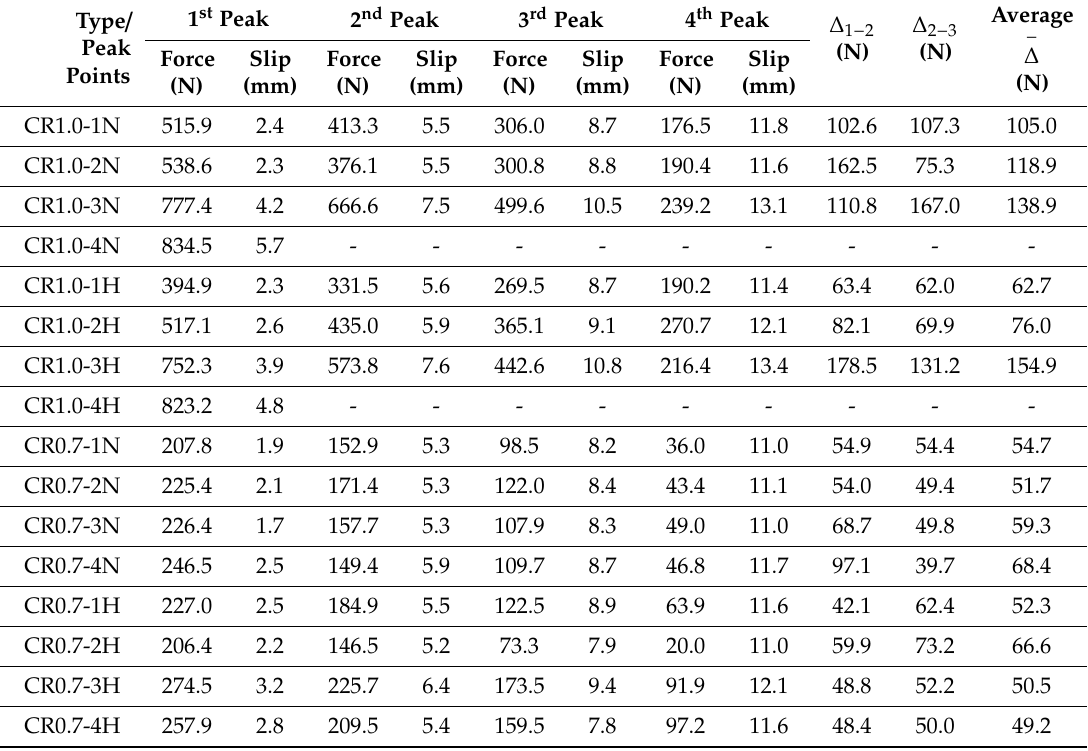
Table 6. Average peak force and response displacement of crimped